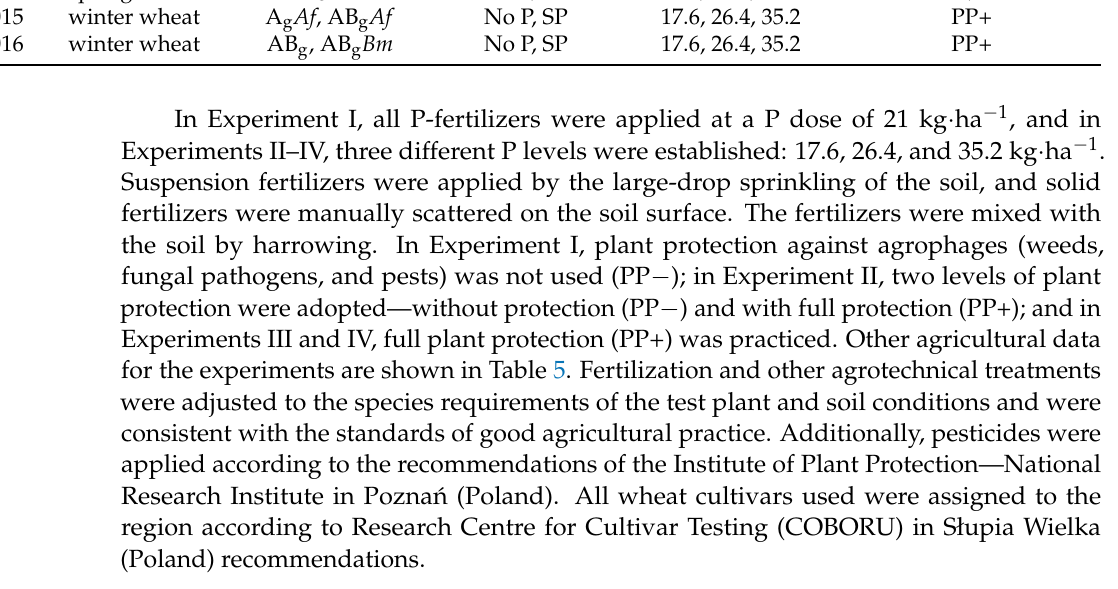
Table 5. Basic agricultural data for the